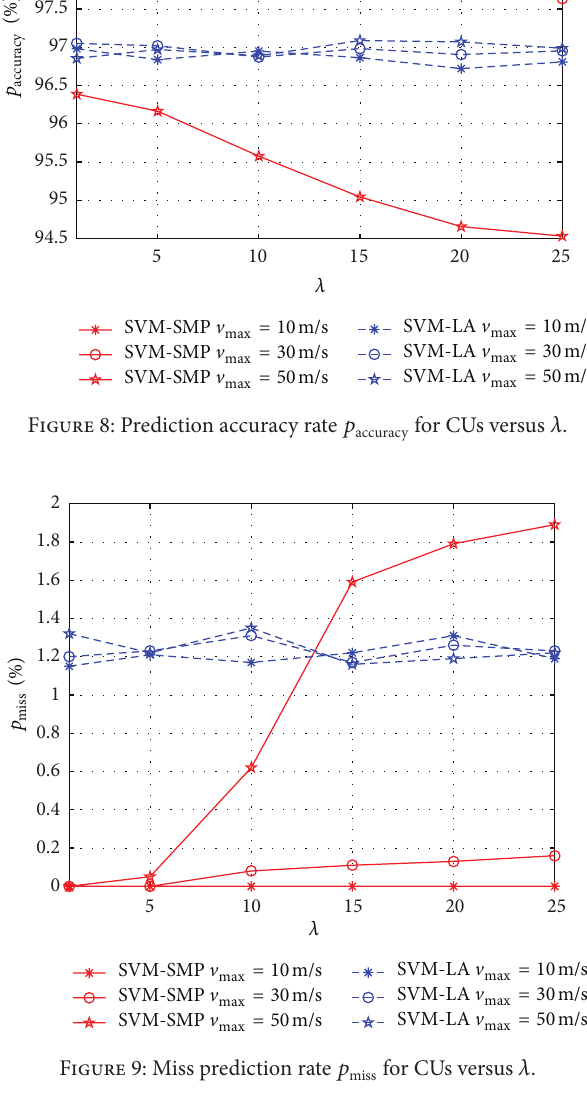
Figure 9: Miss prediction rate 𝑝